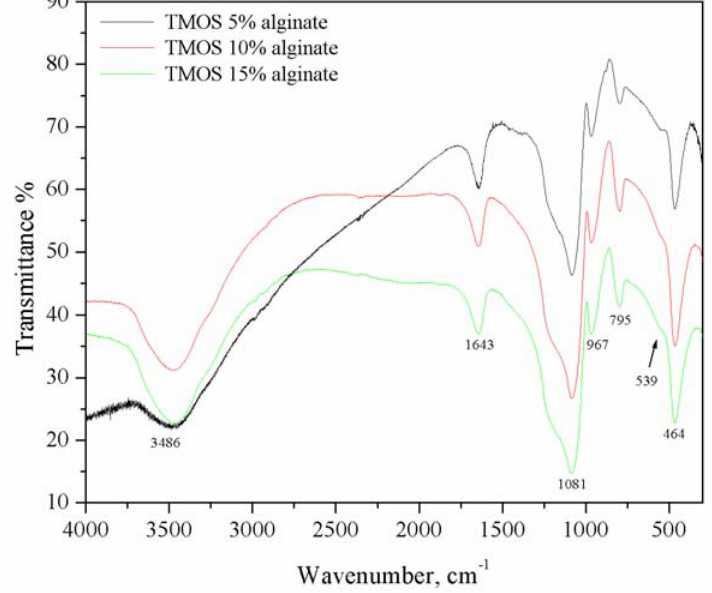
Fig. 4 FT-IR-spectra silica nanocomposite hybrid (TMOS), containing different quanti- ties Calcium